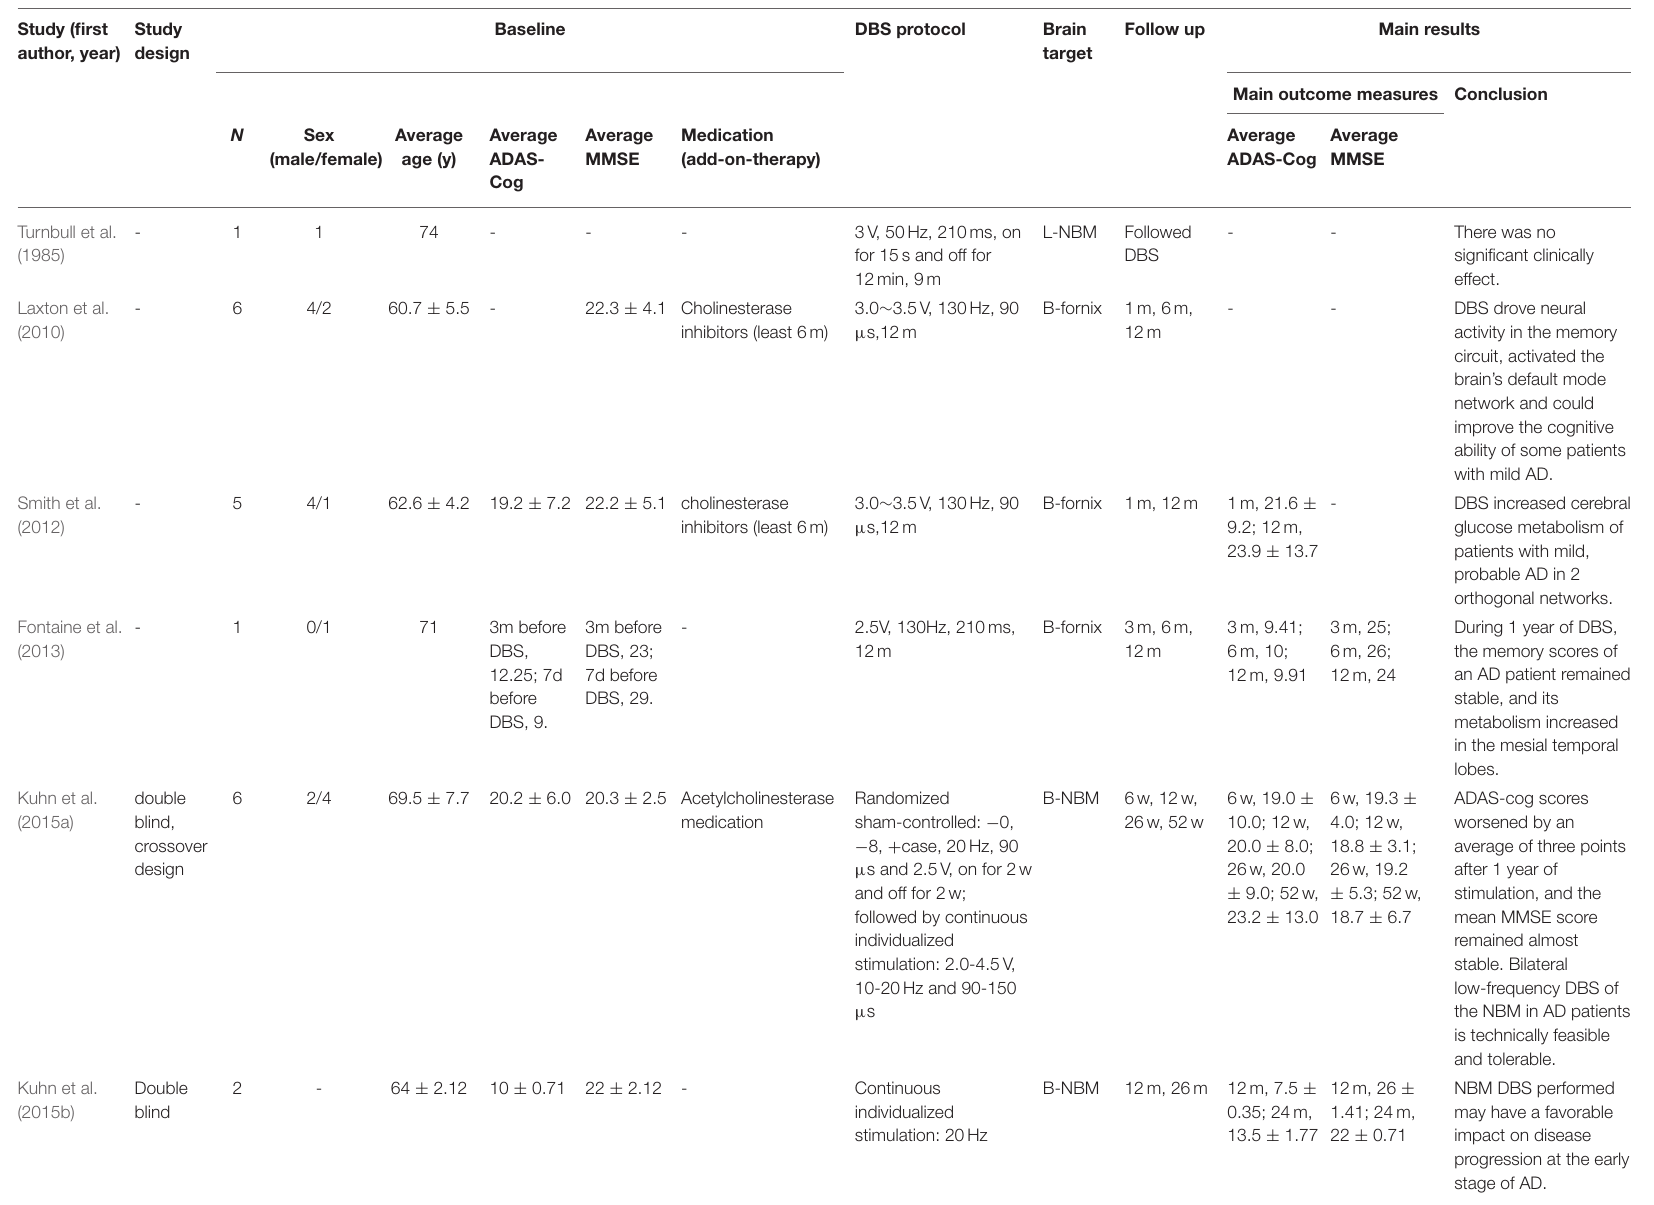
TABLE 1 | The human clinical study of DBS in